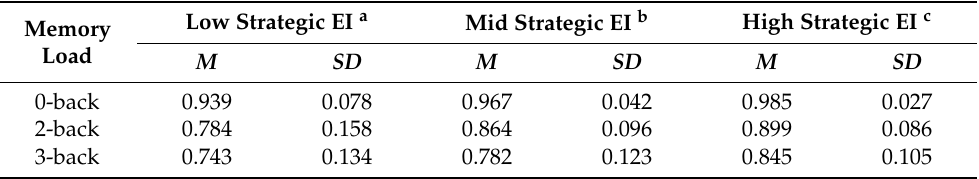
Table 3. N-back accuracy rates at each load level for different Strategic EI